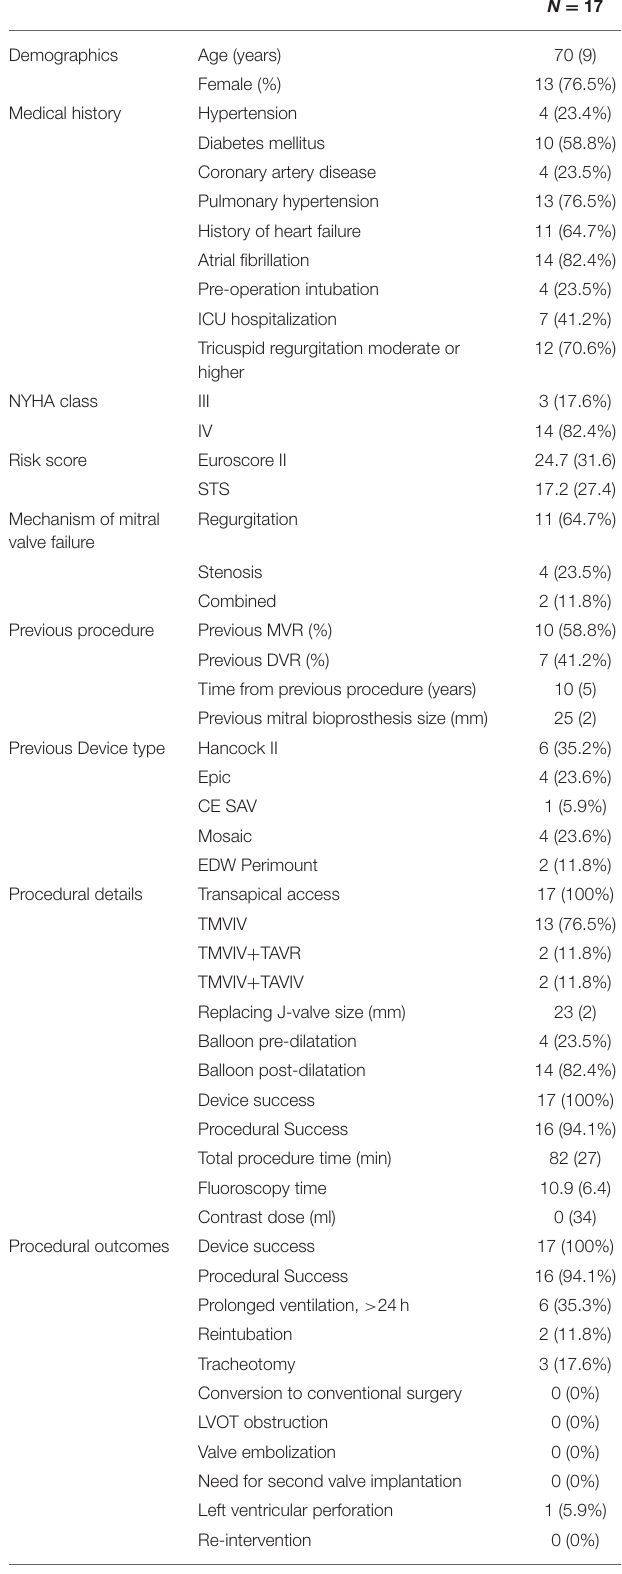
TABLE 1 | Baseline characteristics and procedural